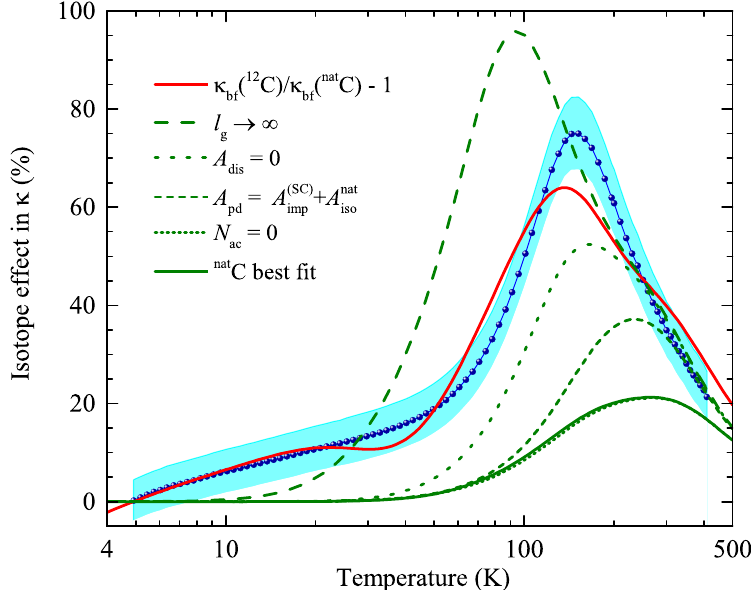
Figure 5. Calculated isotope effect in thermal conductivity κ (12) ( T ) / κ (nat) ( T ) − 1 as a function of temperature for different sets of scattering processes with adjustable parameters relevant to the sample nat C. Circles are data obtained from measured values of thermal conductivity, the cyan shaded area indicates the uncertainty in experimental data; the red line is the isotope effect from best model fits κ bf ( 12 C ) and κ bf ( nat C ) to the experimental κ ( T ) for samples nat C and 12 C, respectively. The “raw” isotope effect determined from the measured thermal conductivity for the 12 C and nat C samples is shown on this figure (blue circles) for comparison